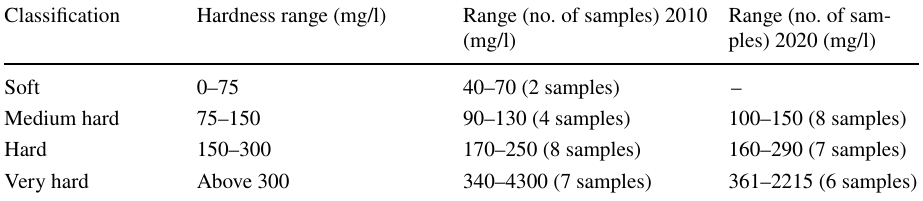
hardness (TH) (WHO